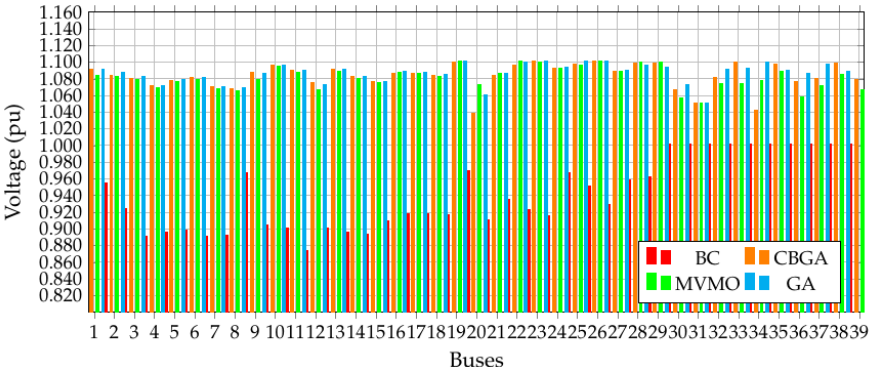
Figure 12. Voltage profile of the IEEE 39-bus test system considering different